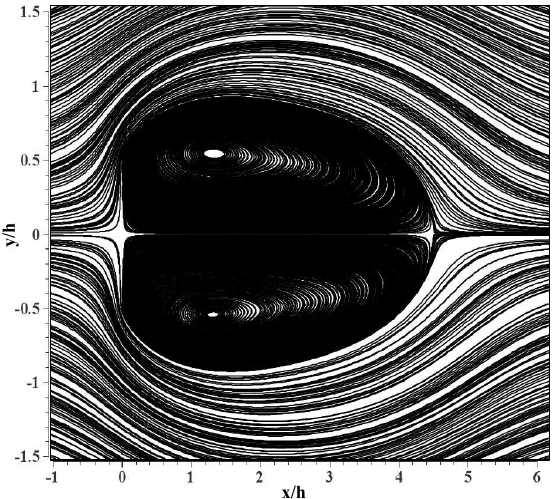
Figure 6. Streamlines plot of the wake central xy − plane calculated by Unsteady k − ε